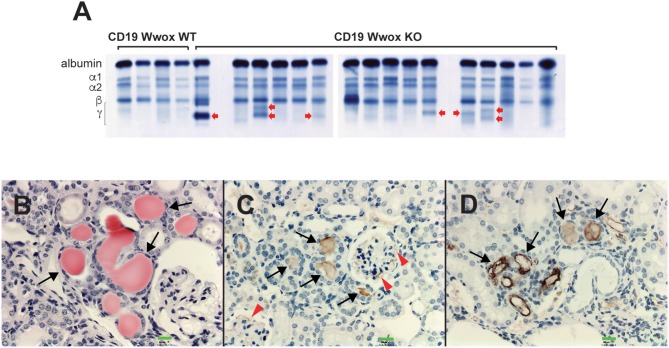
SPEP gels and MM cast nephropathy. Cd19 Wwox KO mice displayed evidence of monoclonal gammopathies. (A) Representative SPEP of serum samples from CD19 Wwox KO and WT control mice. Red arrows point to some representative M spikes. All samples were analyzed in triplicate. Ten of 27 (37%) Cd19 Wwox KO mice displayed detectable M-spikes vs. only 1 of 9 (11%) tested Cd19 Wwox WT control mice. (B–D) Myeloma Cast Nephropathy. H&E staining and anti-mouse IgG of kidney tissue sections from a Cd19 Wwox KO displaying an M spike and poor health at 820 days of age. (B) Black arrows indicate eosinophilic (protein) deposits obstructing kidney tubules. (C,D) same kidney sample as shown in (B) immunostained using a goat polyclonal anti-mouse IgG, light chain-specific peroxidase conjugated antibody, counterstaining with light hematoxylin. Brown staining of the intratubular protein deposits are formed by Ig light chain aggregates (black arrows). Ig light chain deposits can also be observed in the mesangial area of glomeruli [red arrowheads in (C)]. All microphotographs taken at 20x magnification, 100 μM scale bars are shown.